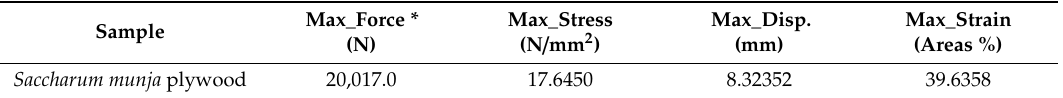
Table 4. Compression test results of phenol-furfural / MMT clay based high-pressure composite by UTM.